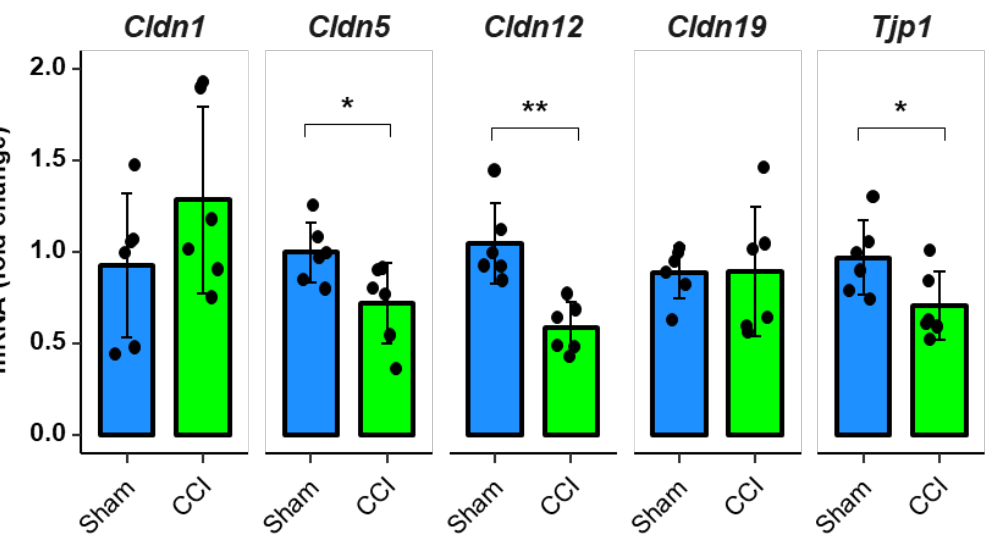
Figure 3. Tight junction protein mRNA expression in rat DRGs is downregulated one week after CCI. Wistar rats were treated with CCI. Relative mRNA expressions of Cldn1 , Cldn5 , Cldn12 , Cldn19 , and Tjp1 (ZO-1) in comparison to sham operated animals were analyzed with qPCR after one week. ( n = 6; Cldn5 : p = 0.0338; Cldn12 p = 0.0021, Tjp1 (ZO-1) p = 0.0419. No variance homogeneity: Cldn19 rats. Welch two-sample t -test, Wilcoxon rank sum test: * p < 0.05, ** p < 0.01).